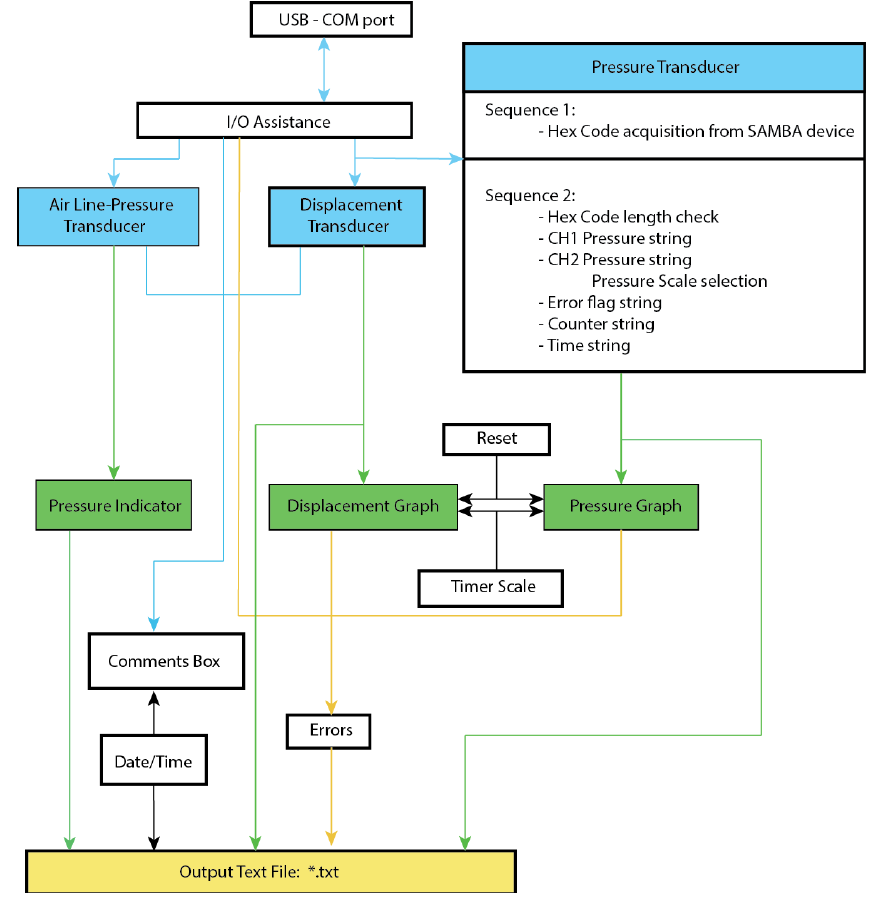
Figure 4. A block diagram of the components utilized in the module developed for the Labview program to interface with the signal transducers and screen output (blue and green boxes,